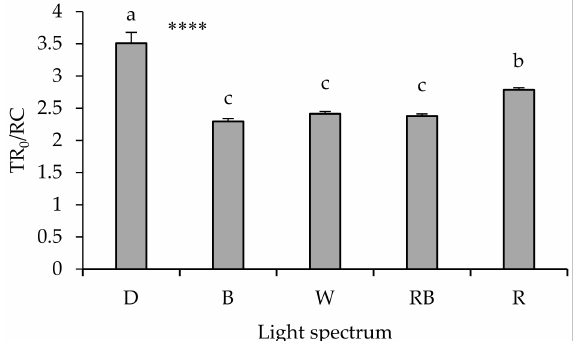
Figure 7. Specific energy fluxes per reaction center (RC) for trapped energy flux (TR 0 /RC; equations and explanations in Table 1), from the fluorescence transient exhibited by leaves sampled from grafted watermelon seedlings exposed for 12 days to either darkness (D) or different light quality regimes [blue (B), white (W), red and blue (RB), as well as red (R); see spectrum in Supplementary Figure S3]. Photosynthetic photon flux density was 20 ± 1 µ mol m − 2 s − 1 during the first 2 days, and 50 ± 1 µ mol m − 2 s − 1 during the following days. Nine plants per treatment were assessed. Different letters indicate that values are significantly different at p < 0.01 according to Duncan’s multiple range tests. Bars represent SEM. Significance at the 0.0001 probability level is indicated by